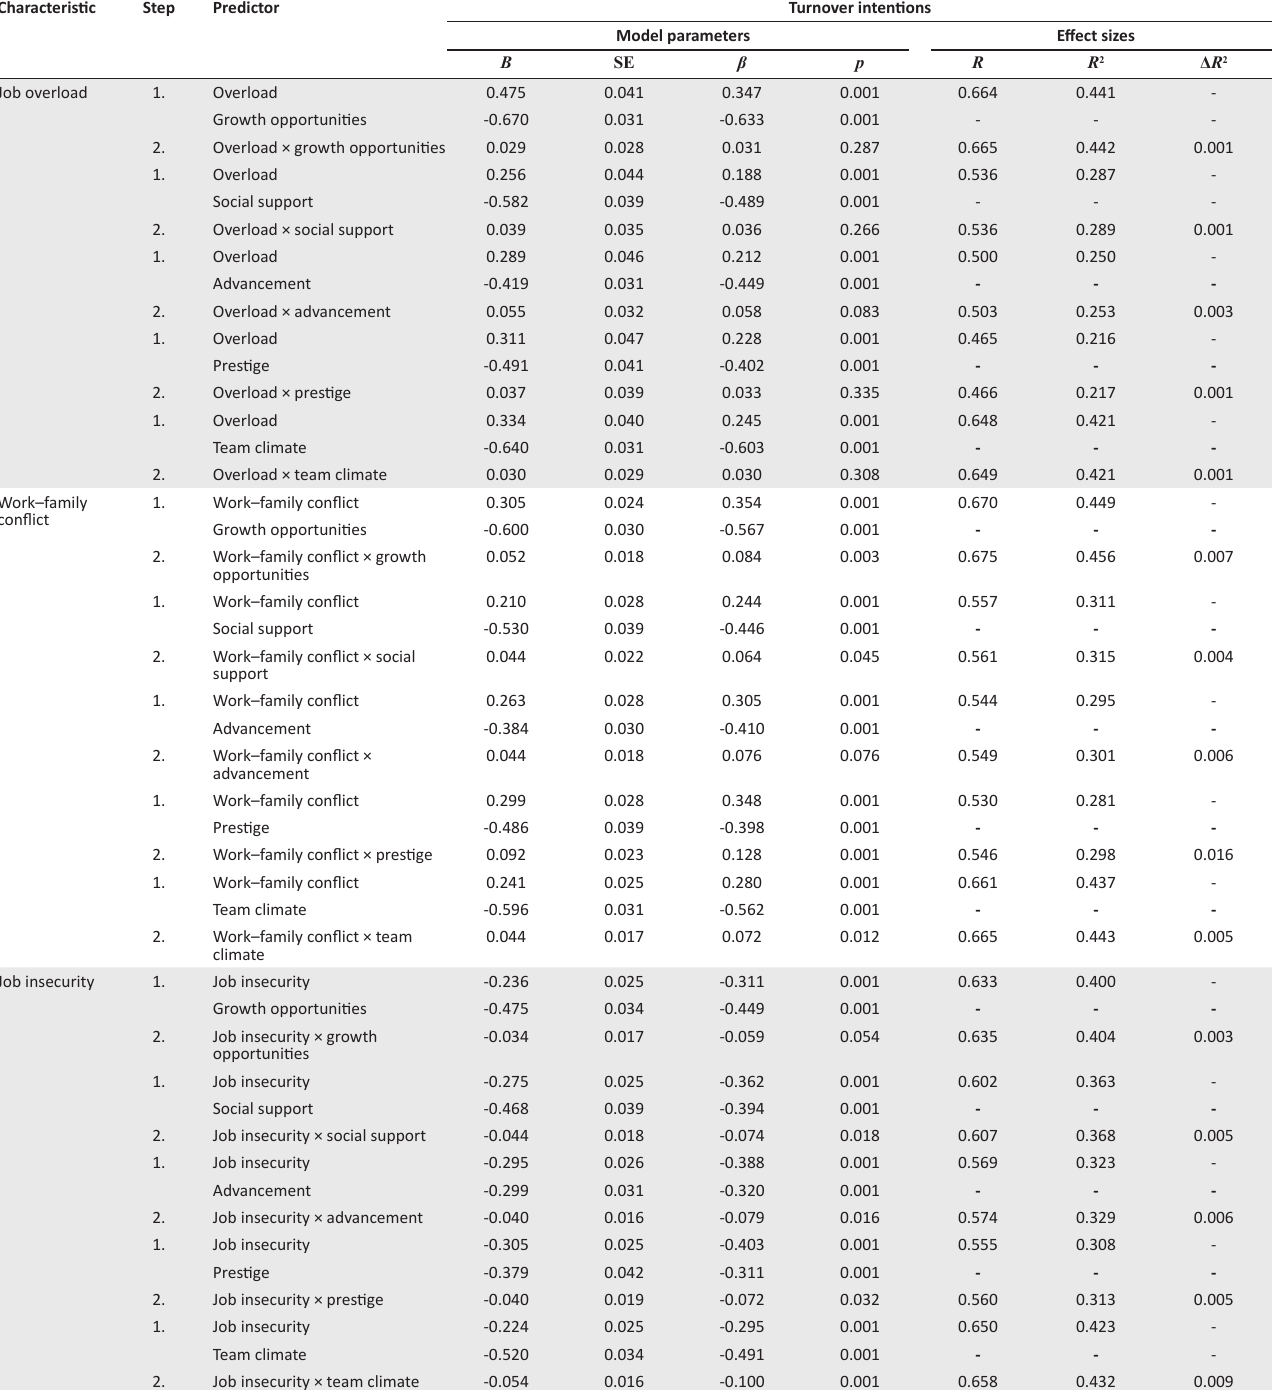
TABLE 4: Results of the moderated regression analysis: Interactions between job resources and job demands in predicting turnover intentions ( n = 851). Characteristic Step Predictor Turnover